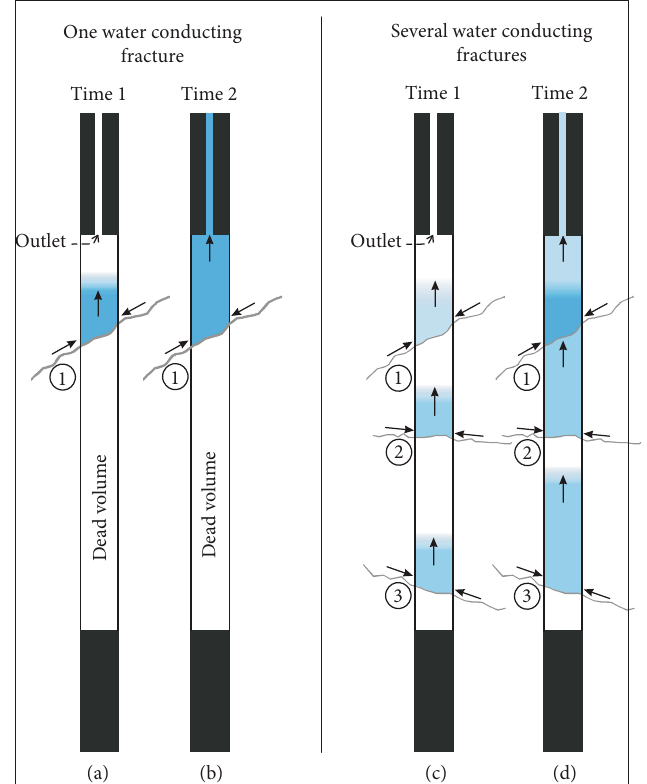
Figure 2: Schematic drawing of two di ff erent situations of the water yielding fractures in an isolated borehole section (modi fi ed from [49]). The blue colour intensity illustrates the amount of formation groundwater in the borehole section during pumping. The presence of a single water-bearing fracture in the upper part of the borehole section, close to the outlet of the section (fracture ① in (a) and (b), on the left part of the fi gure), is a favourable situation since the rest of the water volume beneath the fracture will stay trapped, regardless of the removed amount of water from the borehole section (i.e., the lower part of the isolated section is a dead volume). Figure (a) illustrates the moment shortly after pumping starts (time 1) when the water from the only fracture has not reached the outlet yet. Figure (b) shows that after a while (time 2) all the water leaving the section is formation groundwater. If there are several fractures in the section ((c) and (d) in the right part of the fi gure), the section water between the fractures will contribute to the sample until the formation groundwater from the deepest fracture reaches the outlet: shortly after pump starts (c), no formation water has reached the outlet yet; after a certain time (time 2 in (d)), formation groundwater from fracture ① has reached the outlet and formation groundwater from fracture ② has passed fracture ① ; however, formation groundwater from fracture ③ has not yet reached fracture ② and the section water between fractures ② and ③ will still contribute to the sample. In this last case, the water volume that should be extracted prior to collecting a representative sample of the isolated borehole section may become unrealistically